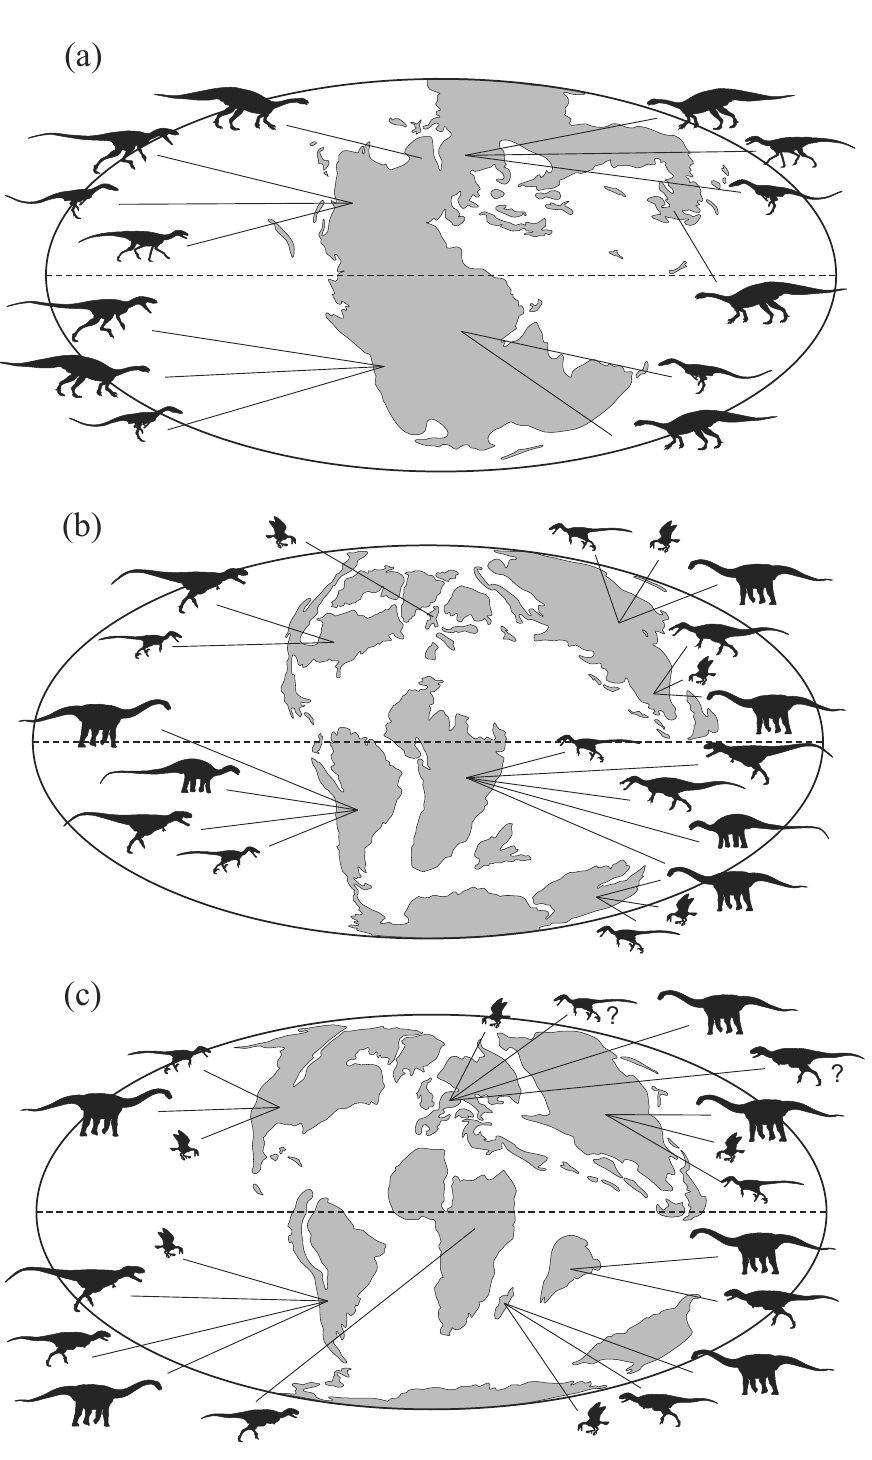
Fig. 4 – Paleogeographic reconstructions corresponding to Late Triassic (a), “middle” (b) and Late Cretaceous (c). Modified from Blakey (2006). The outlines (as in Figs. 1, 4) indicate other occurences of dinosaur/dinosauromorph clades recorded in Brazil during Carnian-Norian, Aptian-Cenomanian, and Campanian-Maastrichtian